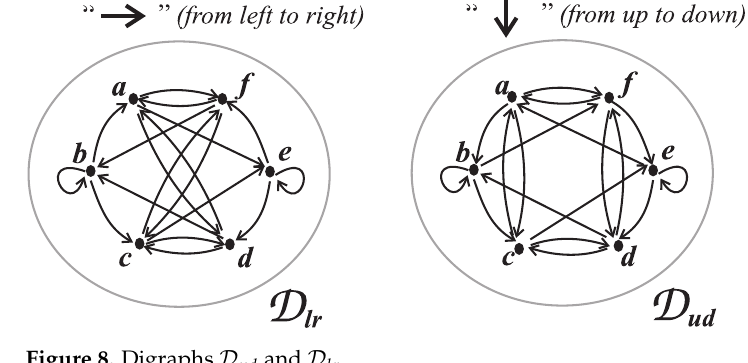
( 3 ) ( right ) with their common 4